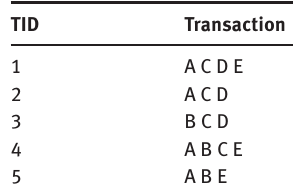
Table 3: Original Database DB.